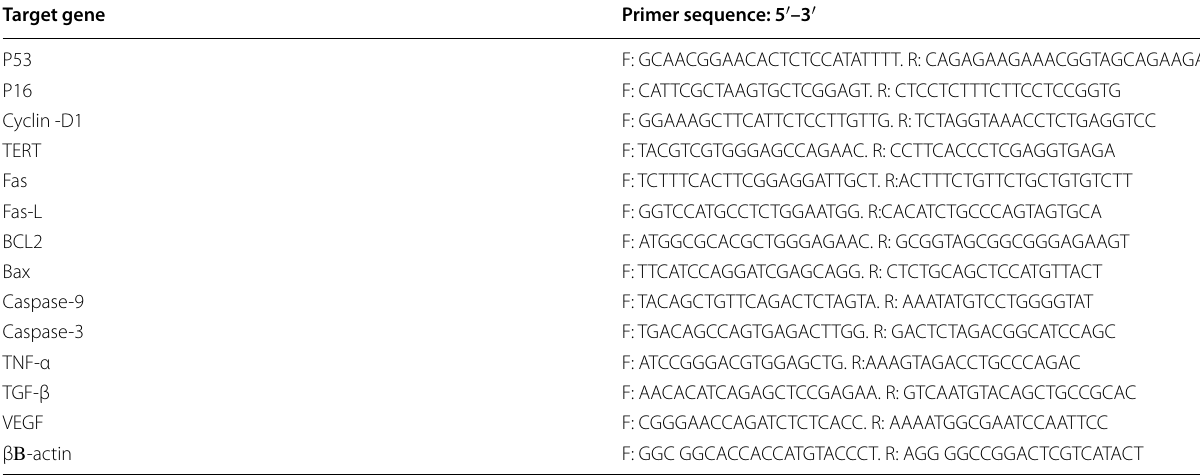
F: is a primer for forward. R: is a primer for reverse